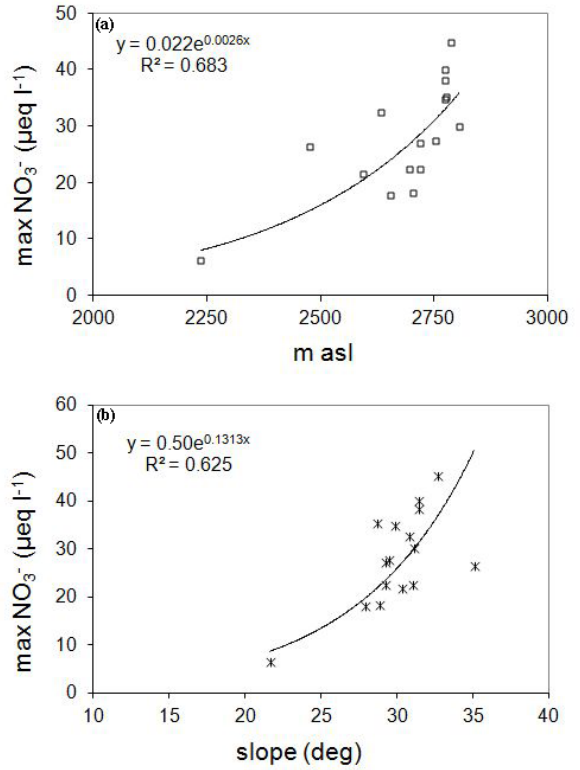
Fig. 5. Relationship between the maximum NO3 concentration in catchment outflow and (a) elevation, (b) slope, for high-elevation watersheds of the Val